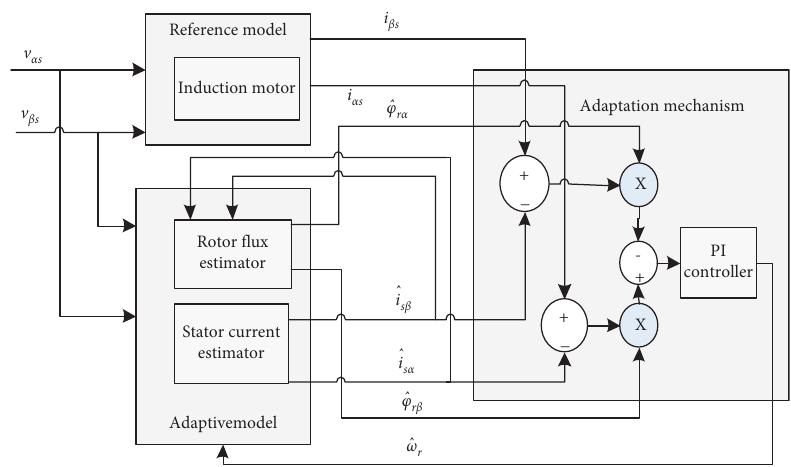
Figure 3: Adaptation mechanisms for the stator current-based MRAS speed estimator.